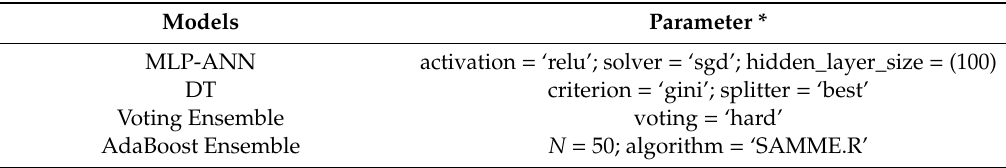
Table 6. Learning models’ parameters.